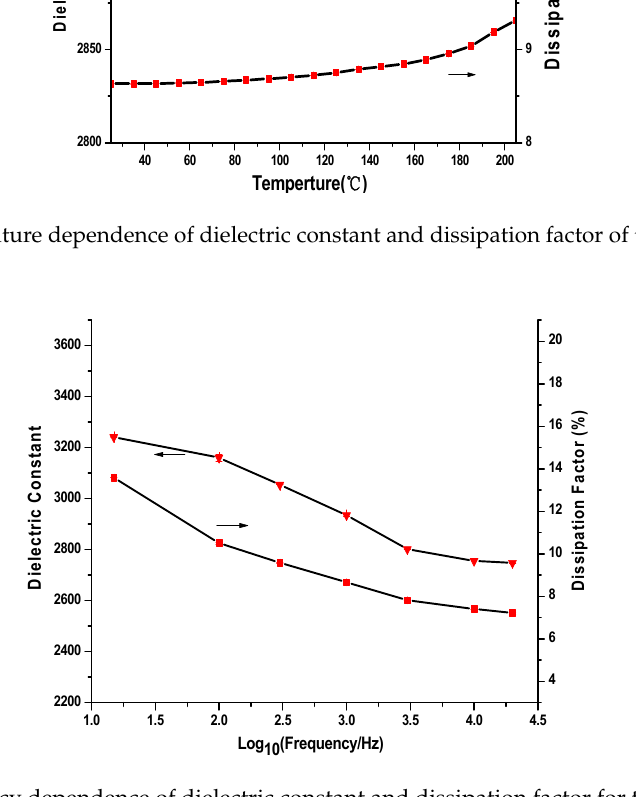
Figure 12. Frequency dependence of dielectric constant and dissipation factor for the BTO thin film at 25 °C.